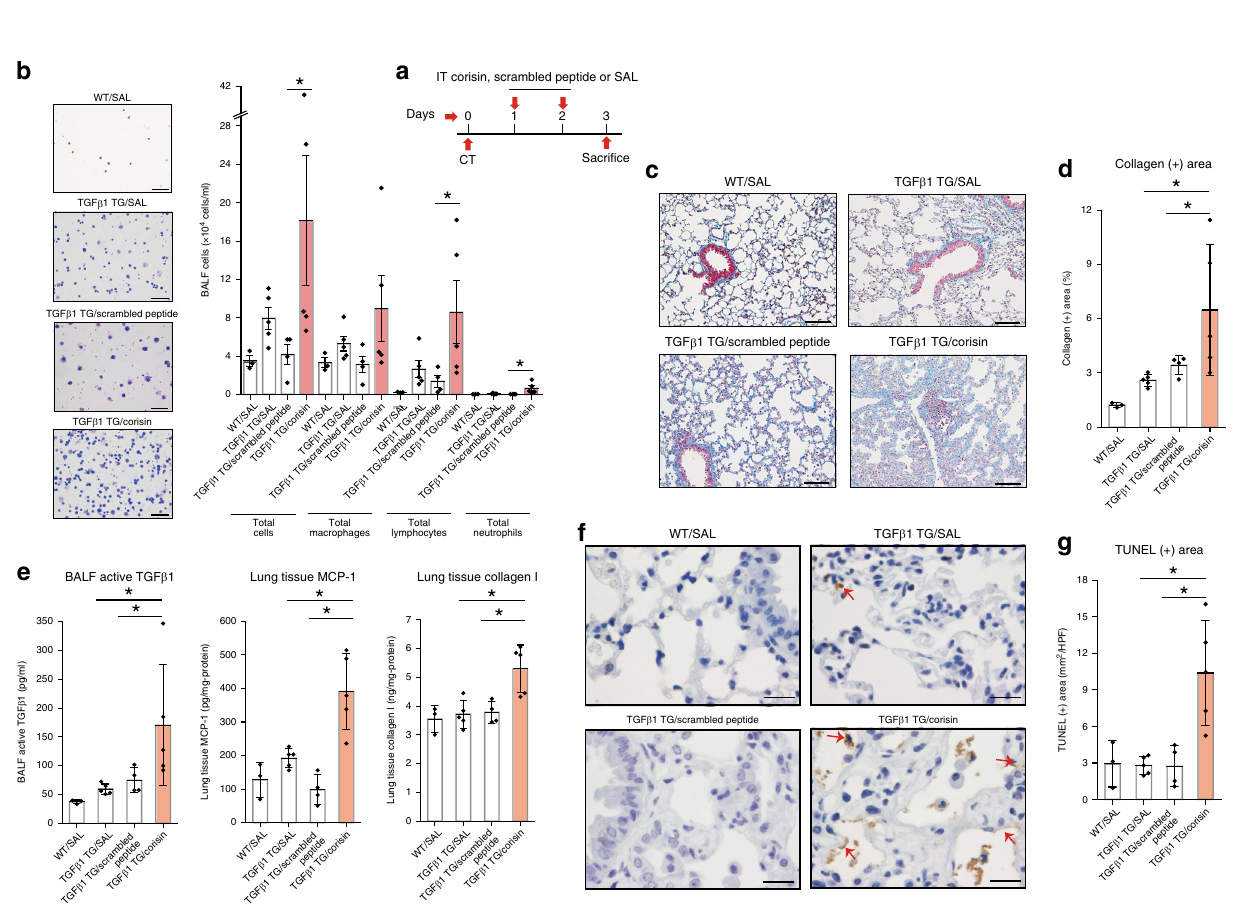
Fig. 5 Structure prediction and apoptotic activity of corisin. The full length of the transglycosylase 351 from Staphylococcus nepalensis strain CNDG was submitted to the protein structure prediction search engine at Swiss model (https://swissmodel.expasy.org/) but the full-length structure aligned with proteins of <20% identity. a – c However, using the pro-apoptotic peptide alone, a model was predicted by the search engine through a structural alignment with the entry 6gi4.1.A, an endo-type membrane-bound lytic murein transglycosylase A, with which it (peptide) shares 46.88% identity. d , e Flow cytometry analysis of A549 alveolar epithelial cells cultured for 48 h in DMEM medium containing increasing concentrations of the pro-apoptotic peptide (corisin from Peptide Institute Incorporation, Japan). Each concentration with n = 3 (triplicates). Bars indicate the means ± S.D. Statistical analysis by ANOVA and Tukey ’ s test. * p < 0.001. f Electron micrographs of A549 cells cultured in the presence of saline or corisin. Representative microphotographs out of two experiments with similar results are shown. Scale bars indicate 1 µ m. The source data underlying e are provided in the Source Data fi le.